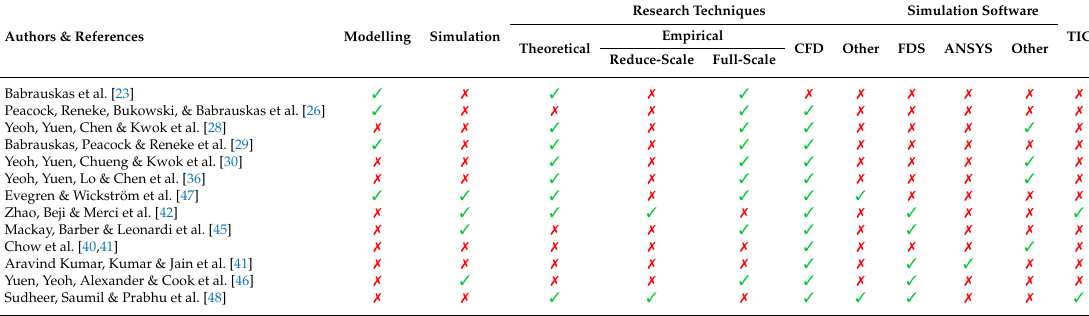
Table 5. Reference summary about modelling and simulation of flashover